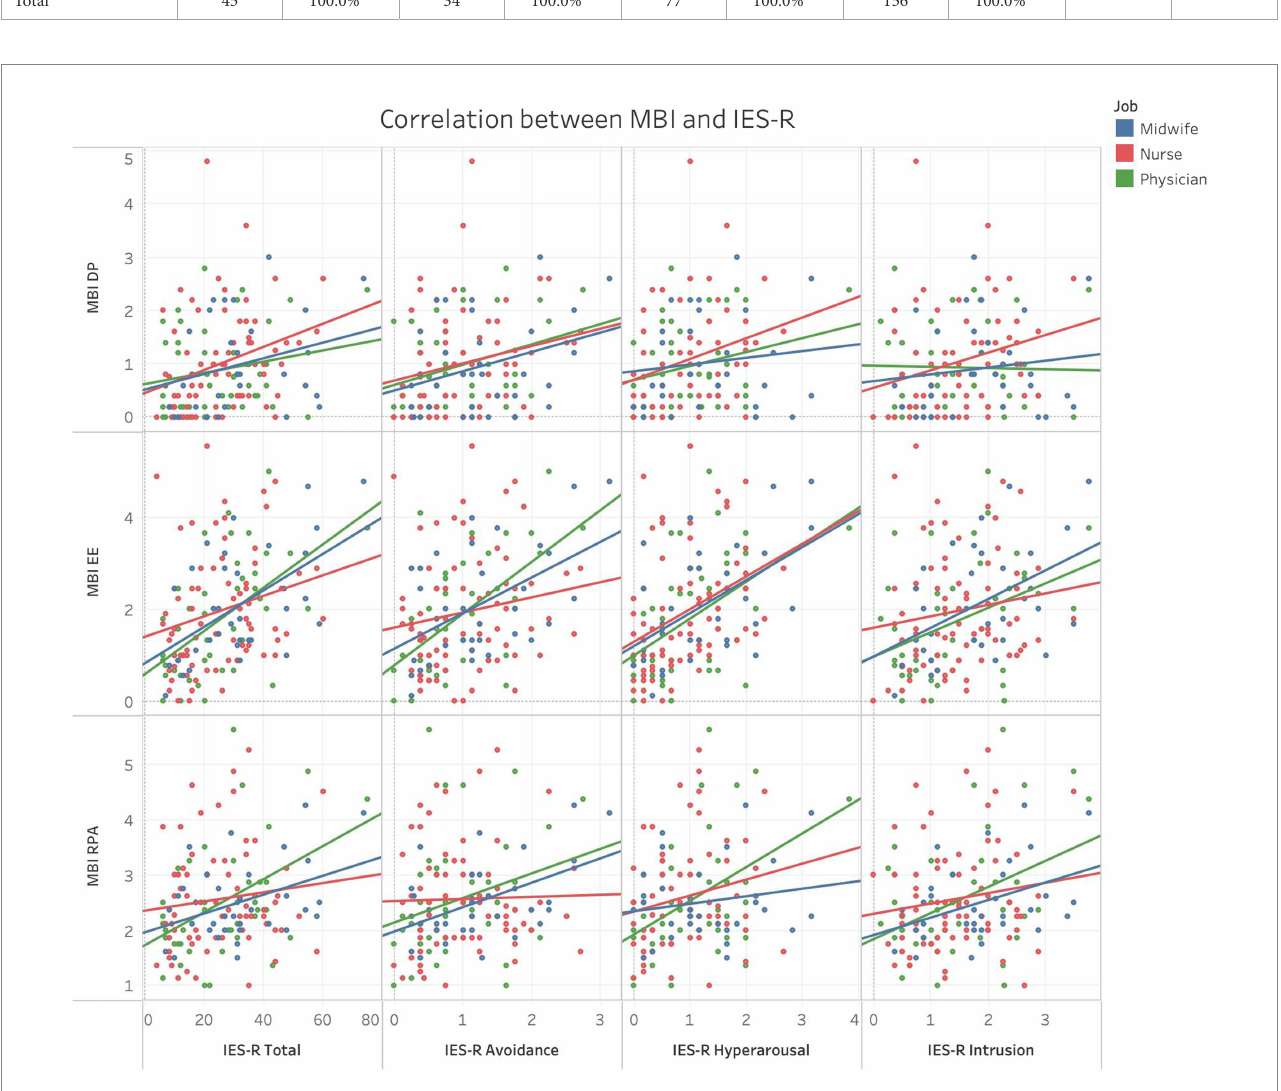
FIGURE 6 Scatter plots showing correlations between MBI subscales scores and IES-R total and subscales scores in different HCPs